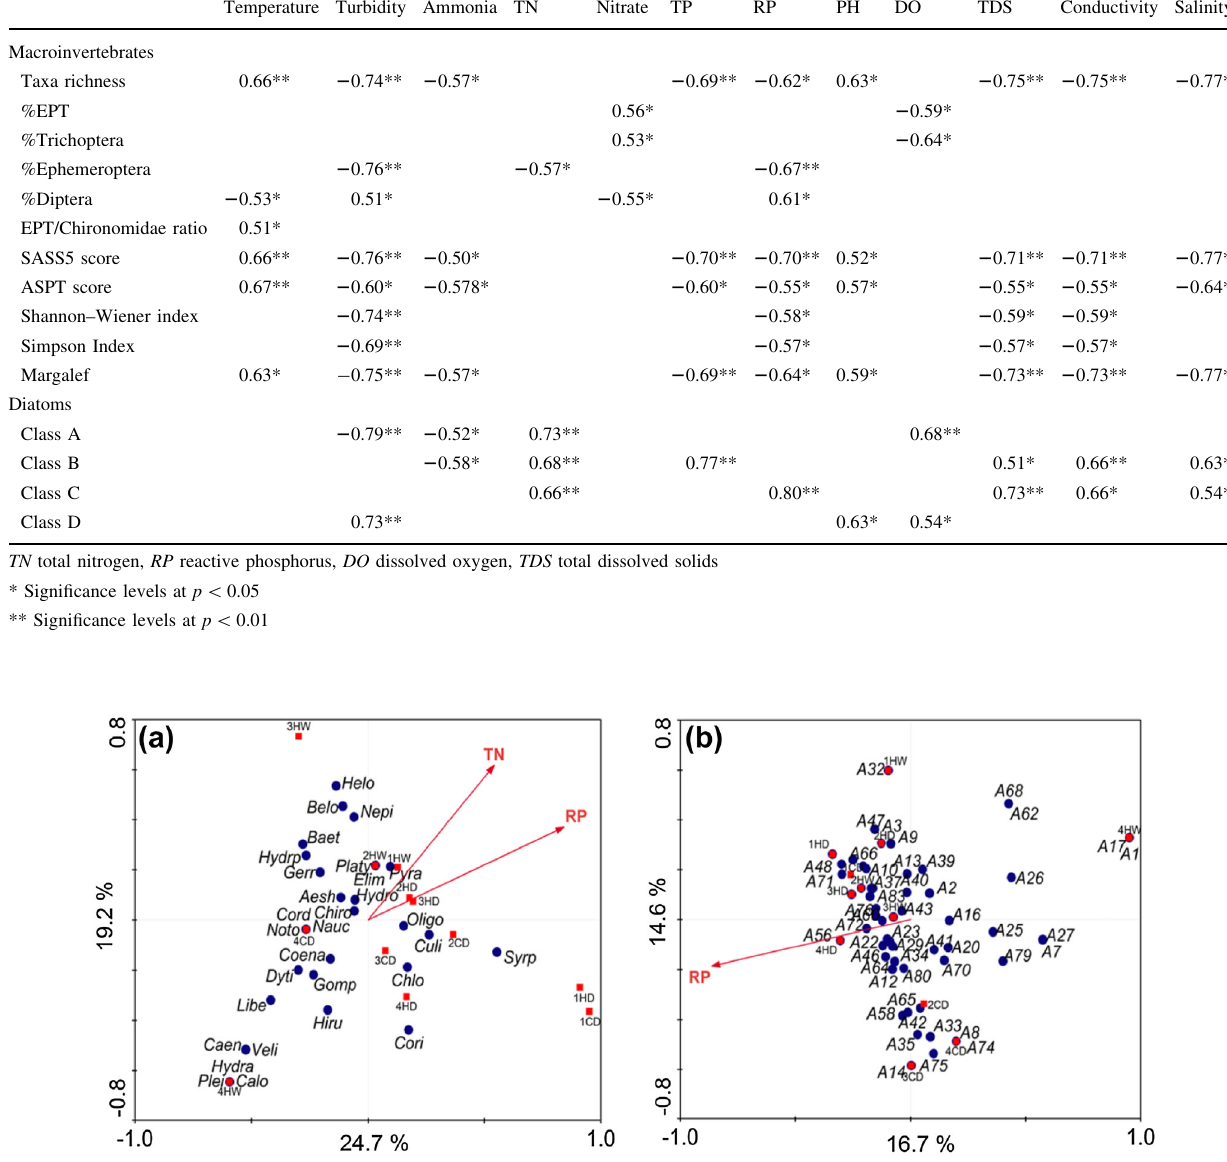
next to the seasons are site numbers. Abbreviations are further highlighted in Tables 1, S1 and